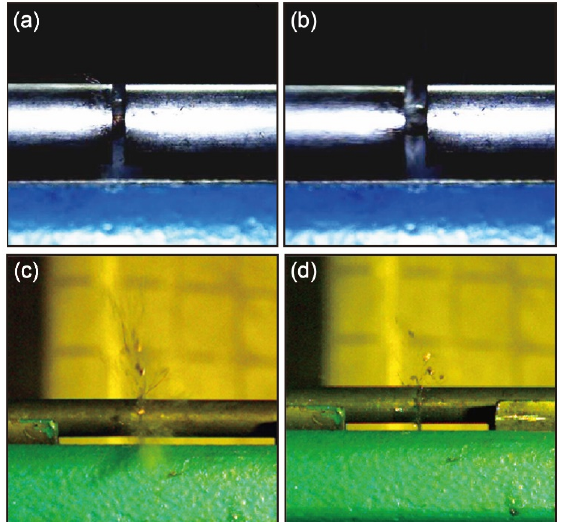
Figure 6. High speed photographs of W-30Cu composites under dynamic compression conditions: ( a ) the SCI composite with plastic deformation; ( b ) the BCI composite without plastic deformation; ( c ) the destructed SCI composite with tiny debris; ( d ) the destructed BCI composite with several fragments.